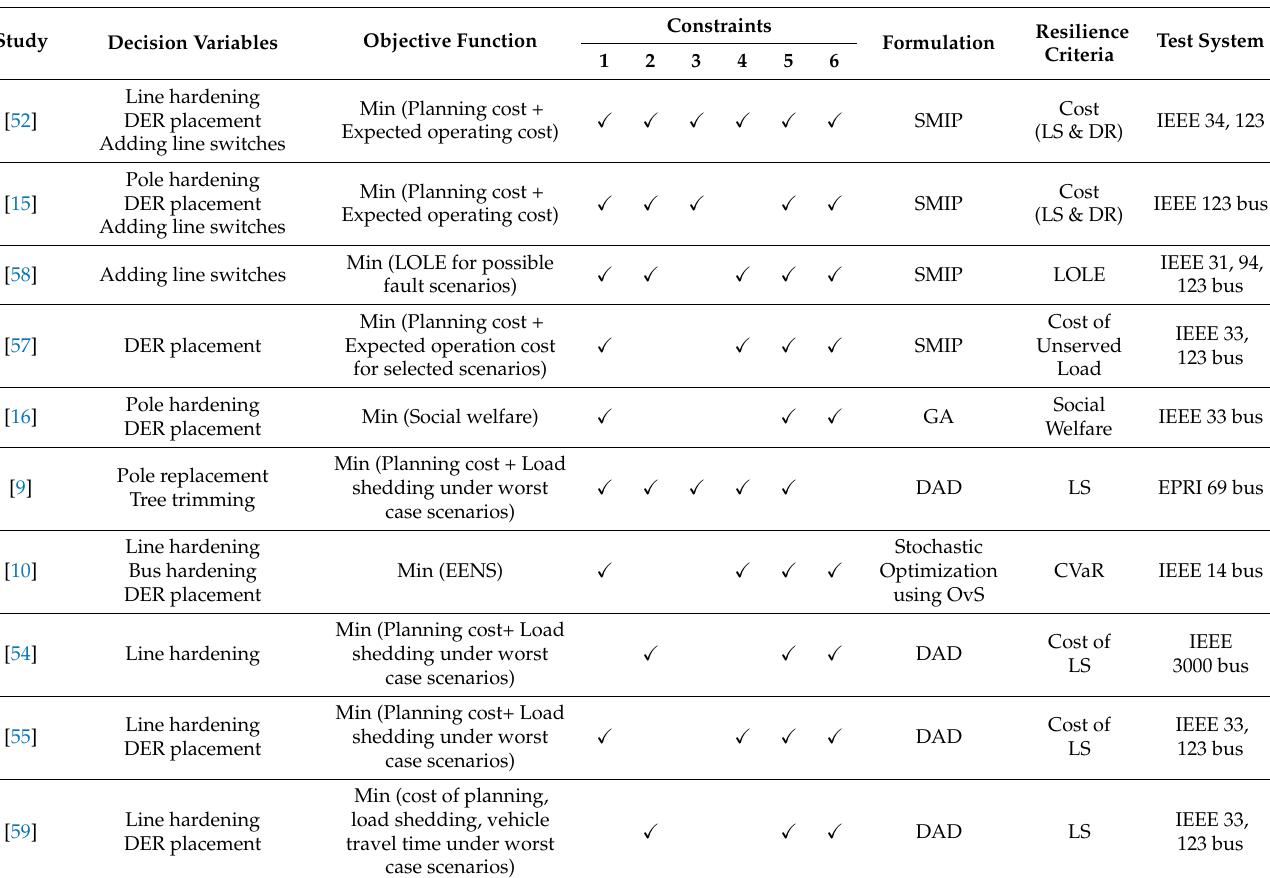
Table 4. Survey of solutions in the literature for infrastructural resilience enhancement. Constraints are listed as (1) budget and investment cost constraint, (2) load shedding amount/cost, (3) repair time/cost, (4) damage status, (5) operation constraints, and (6) other constraints. The